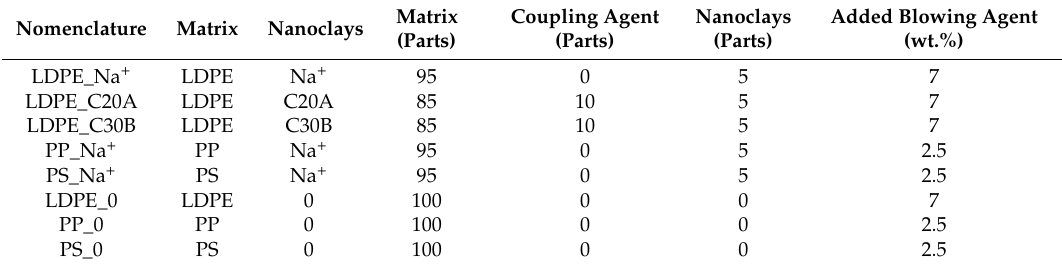
Table 2. Formulations and nomenclature of all foamable nanocomposites used in this